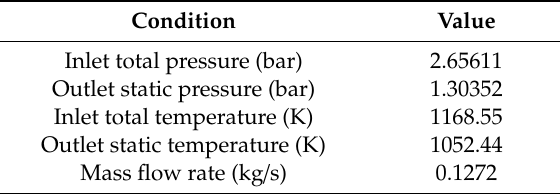
Figure 16. Variation of engine air mass flow rate during compressor speed sweep at each engine speed. Table 4. Design point turbine boundary conditions generated in WAVE.